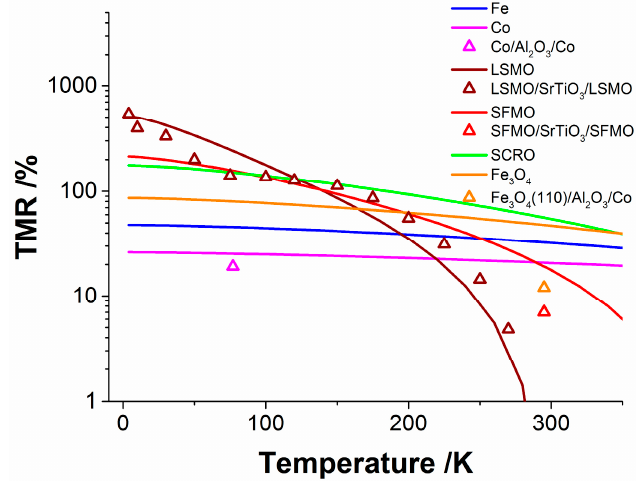
Figure 2. Temperature dependence of the TMR calculated using Equation (7), in comparison with experimental data of Co/Al 2 O 3 /Ni 80 Fe 20 [52], LSMO/SrTiO 3 /LSMO [31], SFMO/SrTiO 3 /SFMO [47], and Fe 3 O 4 (110)/Al 2 O 3 /Co [49].